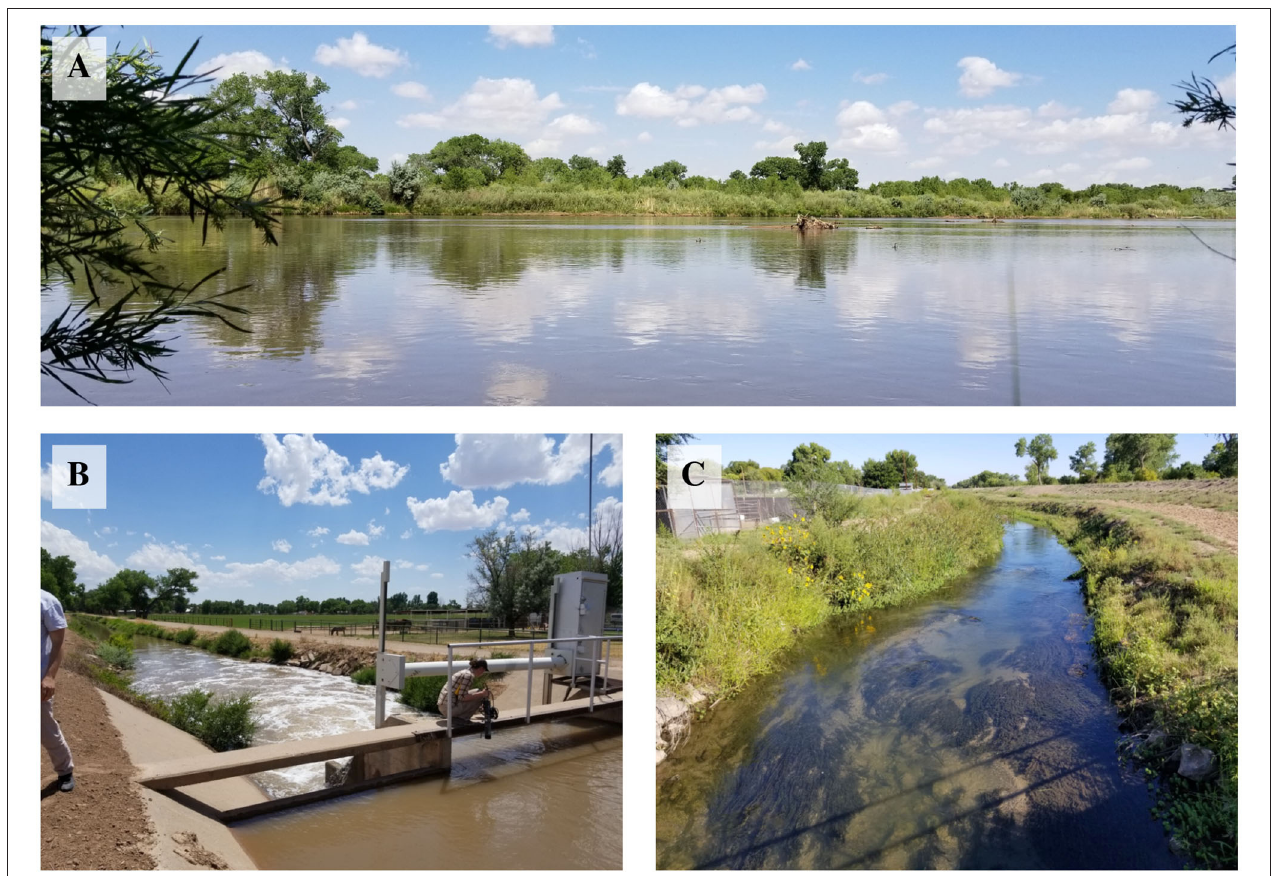
FIGURE 2 | Sampling sites at the (A) Rio Grande ( ∼ 110m wide), (B) Delivery Canal ( ∼ 8m wide), and (C) Drain ( ∼ 6m